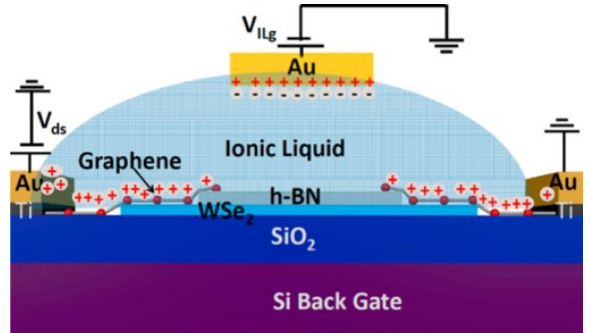
Figure 9. Schematic illustration of the structure and working principle of a hexagonal boron nitride (h ‐ BN)/WSe 2 FET with ionic ‐ liquid ‐ gated graphene contacts. Reproduced with permission from [69], American Chemical Society, 2014.